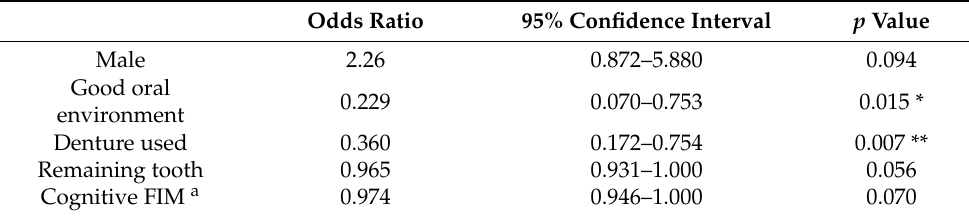
Table 2. Multivariate logistic regression analysis with aspiration pneumonia as dependent variable. Odds Ratio 95% Confidence Interval p Value Male 2.26 0.872–5.880 0.094